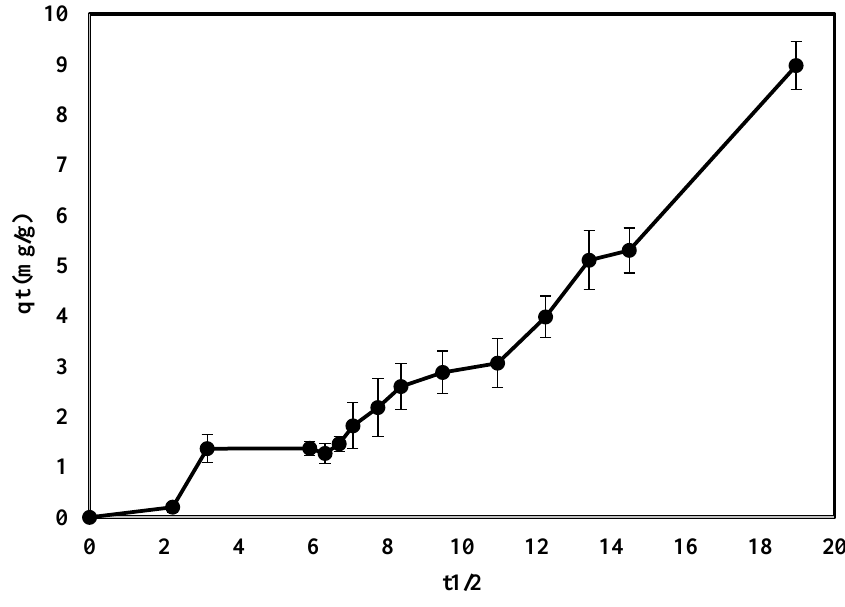
Figure 11. Intraparticle diffusion model.